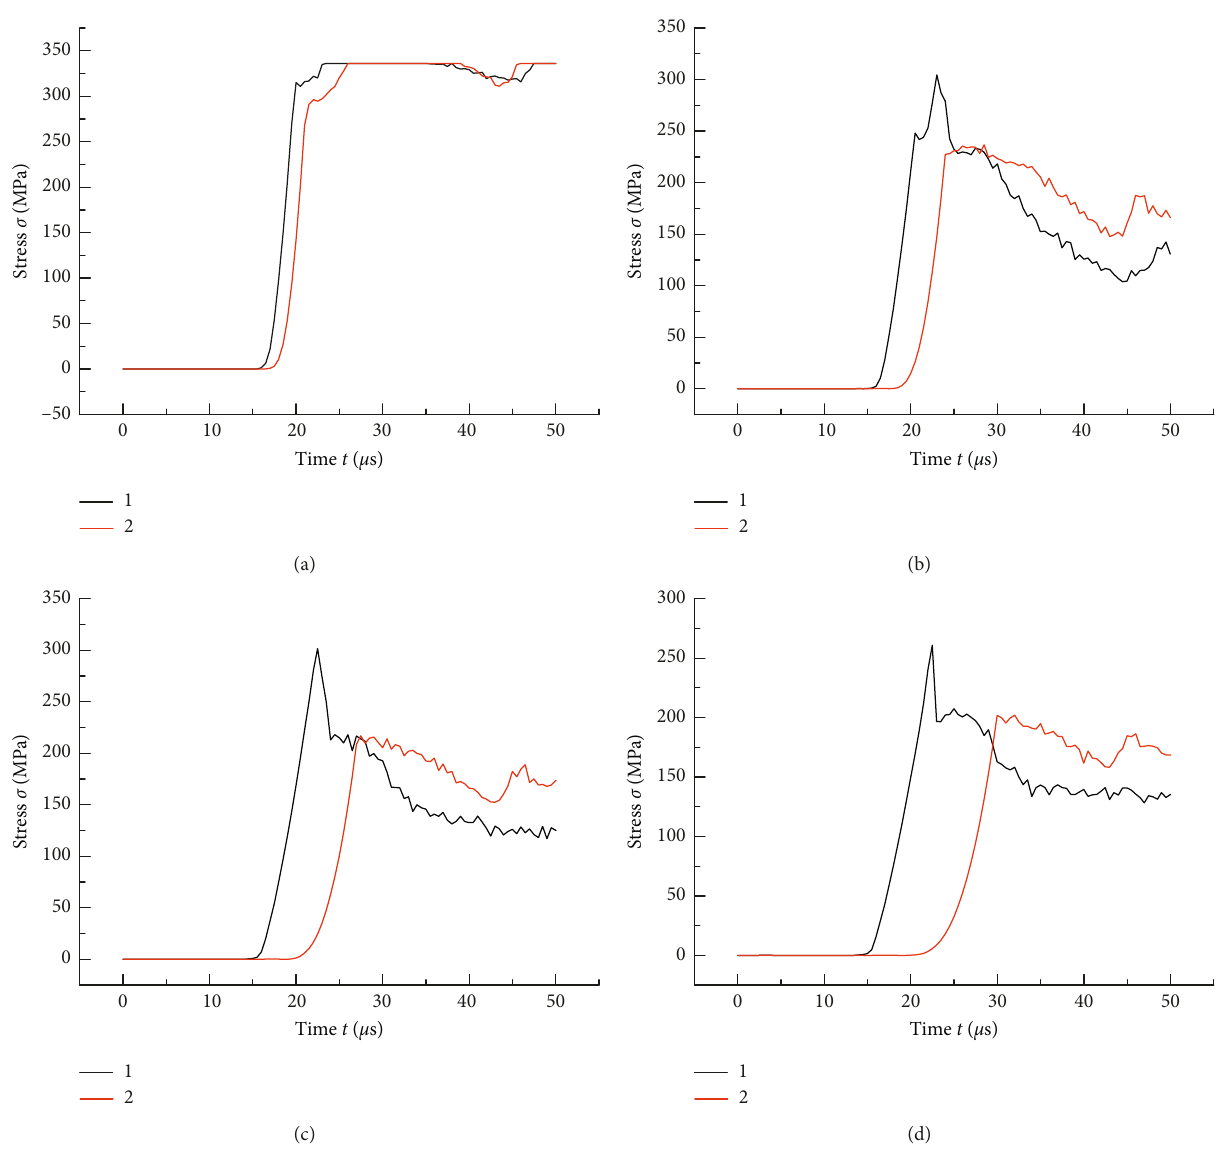
Figure 13: The effective stress change of point 1 and point 2 on empty hole